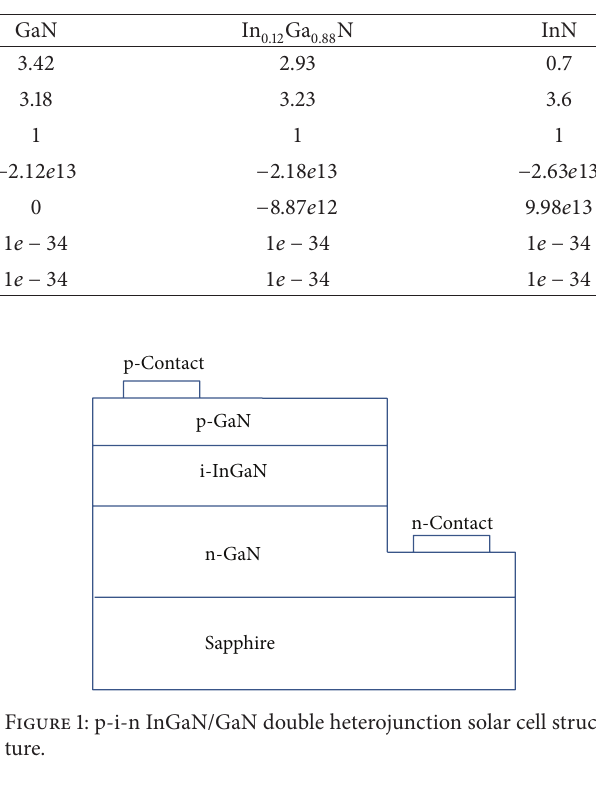
Table 1: Material parameter used in simulation.